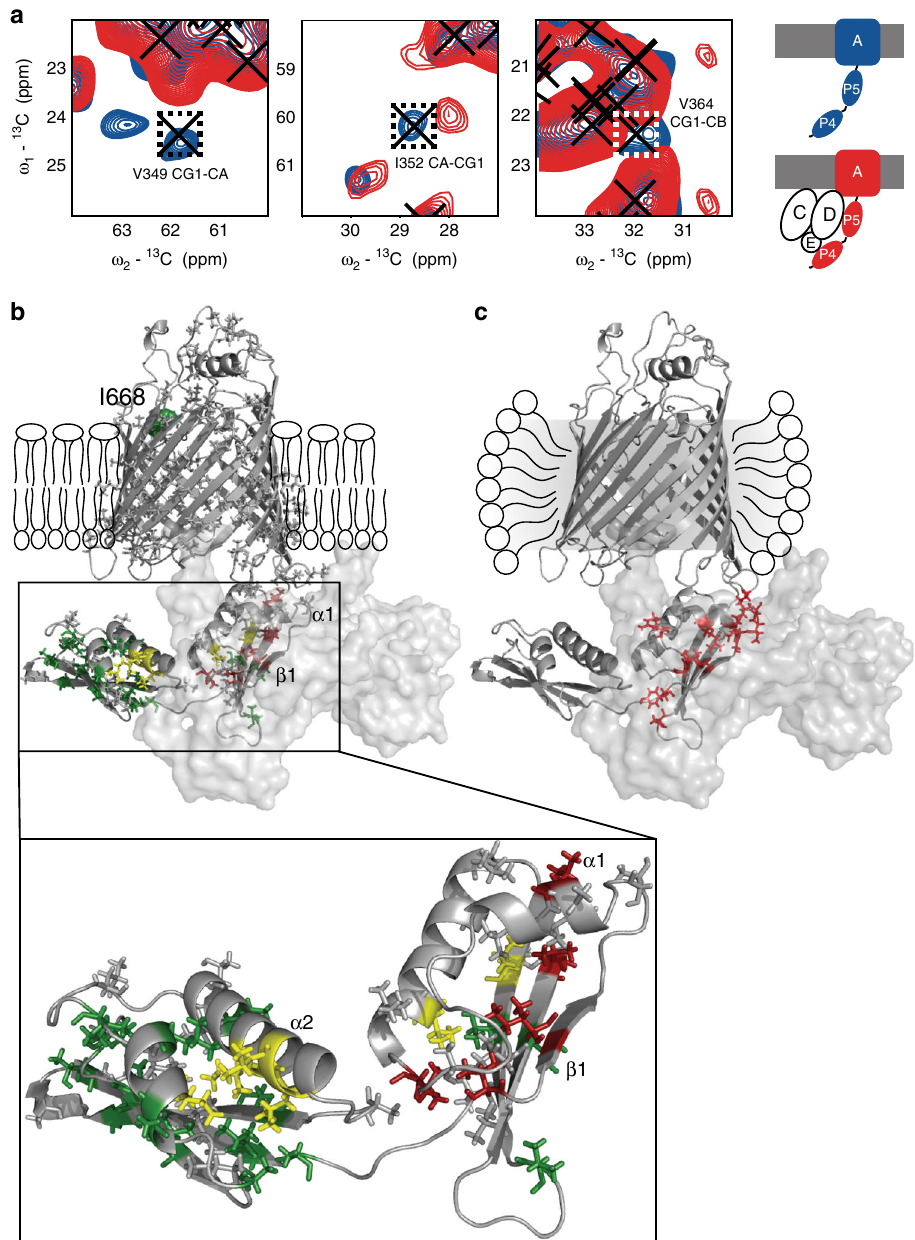
Fig. 3 BamAP4P5 – BamCDE interface in bilayers. a Close up of representative correlations from the 2D 13 C – 13 C spectra of AVLTI labeled BamAP4P5 in liposomes, in the absence and presence of BamCDE (blue and red spectra, respectively). Crosses are assignments of the labeled residues; dashed boxes indicate correlations with chemical shift perturbations above 0.7 ppm. b BamAP4P5 – BamCDE interaction interface as described by ssNMR data in lipid bilayers. Residues as sticks are labeled (i.e. AVLTI), those in gray were not used for analysis. Residues in red show a chemical shift perturbation, those that in yellow indicate an increase in intensity and those that in green do not experience any effect upon complex formation. The zoom-in shows in more detail the interaction interface. Indicated are the structural elements mentioned in the text and residue I668 of EL6 (spheres). c BamA – BamCDE interface as described by all BAM complex crystal structures (PDB 5D0O, 5D0Q, 5AYW, and 5EKQ). Contacts with the BamCDE complex, in red, were found using PDBePISA 29 on these structures. BamD and BamE are shown as semi-transparent surfaces in b , c , as well as a schematic representation of the liposome bilayer and detergent micelle are present to aid To investigate β 1 and β 16 and their relative distance we with 15 N-edited C x C x experiments 48 recorded under DNP compared DNP-supported 15 N-edited C x C x experiments for conditions that only contain signals from sequential 13 C – 15 N labeled residue pairs (Fig. 4d, e). With this strategy we were able short and long mixing times (see Supplementary Fig. 7 for to tentatively assign four residues, namely F428, I430 and I806 of diagram of the experiments and Supplementary Figures 6b and c β 1 and β 16, in addition to the helical I668 residue of EL6 21 for entire spectra). As expected, the resulting spectra before (Fig. 4d, blue) and after (Fig. 4d, red) complex formation using (Fig. 4d, e, black crosses, see also Supplementary Fig 5b and short mixing times were similar with the exception of I806 that Supplementary Table 3).